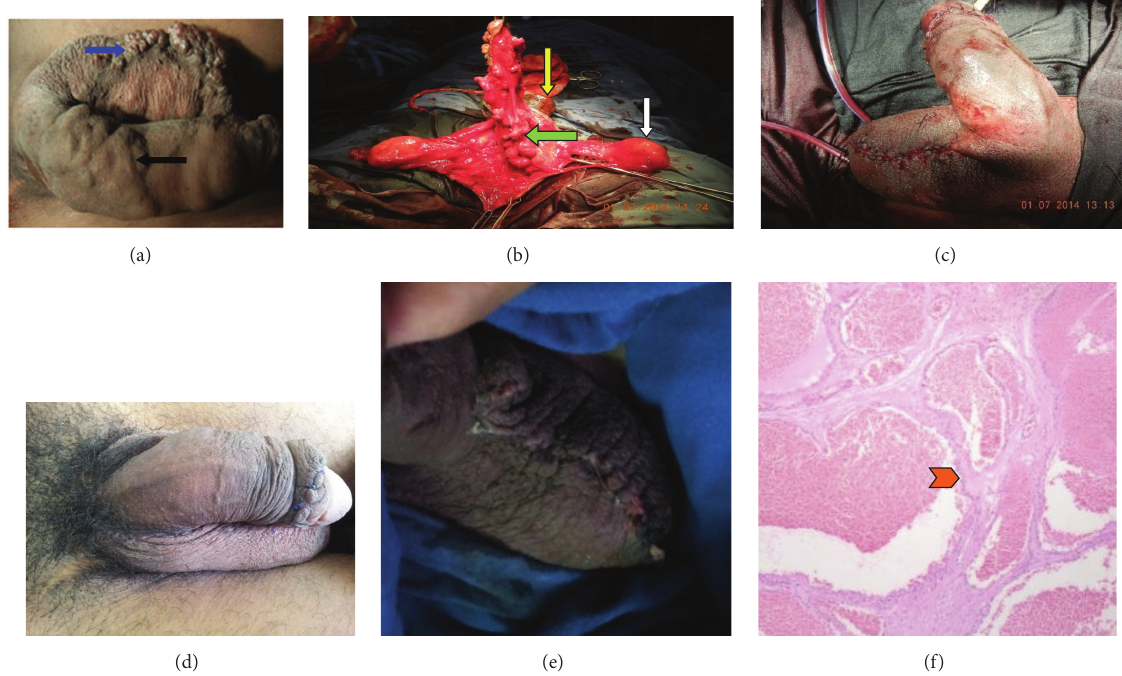
Figure1:(a)Showingpreoperativephotographofthehemangioma:blacksolidarrowshowingthepenilecomponentofhemangiomaandblue solid arrow showing scrotal extension of hemangioma. (b) Showing intraoperative picture: green solid arrow showing the hemangioma tissue dissected from penile shaft, yellow solid arrow shows glans, and white solid arrow shows the testis. (c) Final operative picture with suction drain in situ. ((d), (e)) Postop picture at follow-up showing healed wound with an excellent cosmetic outcome. (f) Showing microscopic picture (H&E stain) endothelium lined vascular channels with intervening thick fibrous septa (red arrow head shows thick fibrous septa characteristic of cavernous